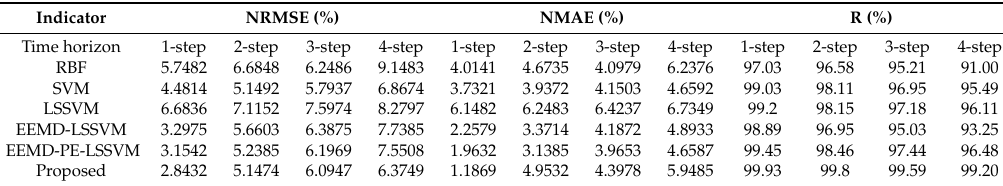
Table 7. The values of NRMSE, NMAE and R for six models in Dataset